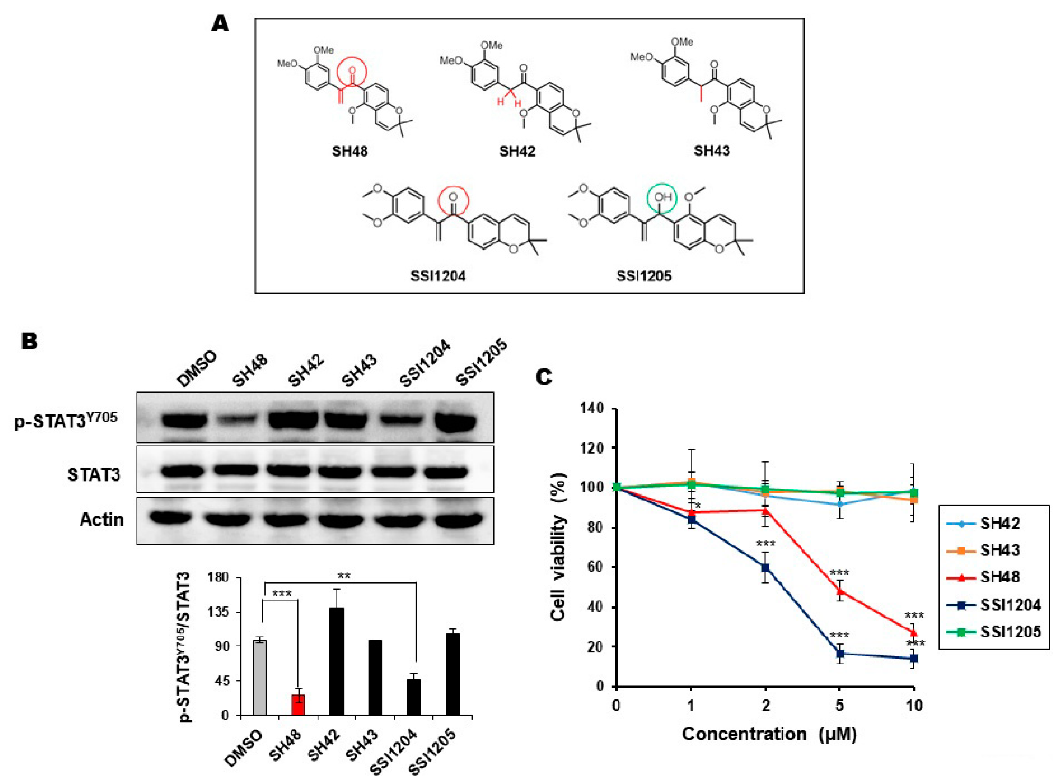
Figure 3. Effects of selected deguelin analogues on the phosphorylation of STAT3 and cell viability. ( A ) Chemicalstructuresof SH48 andSH1203 and theirnon-electrophilicanalogues. Red and green circles denote electrophilic carbonyl and non-electrophilic alcoholic functions, respectively. ( B ) MCF10A- ras cells were treated with 5 µ M each of SH48 SH42, SH43, SSI-1204, and SSI-1205 for 24 h, and the expression of P-STAT3 and STAT3 was measured by Western blot analysis. Actin was measured for the confirmation of the equal amount of loaded protein. ** p < 0.01; *** p < 0.001. ( C ) MCF10A- ras cells were treated with indicated concentrations of SH42, SH43, SH48, SSI1204, and SSI1205 for 24 h. The cell viability was measured by the 3-(4,5-dimethylthiazol-2-yl)-2,5-diphenyltetrazolium bromide (MTT) assay as described in Section 2. * p < 0.05; *** p <